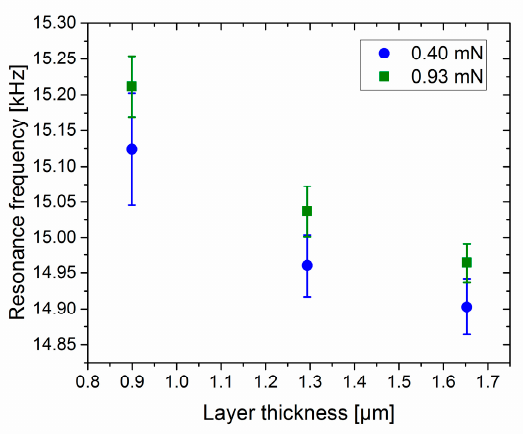
Figure 2. CRS measurement of different PR-layer thicknesses with two contact-forces ( F 0 ) of 0.4 mN and 0.93 mN.